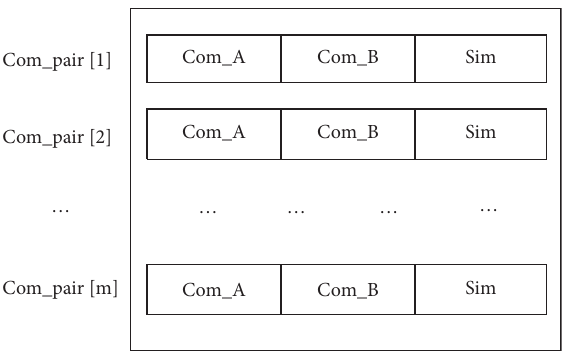
Figure 3: Com_pair data structure.